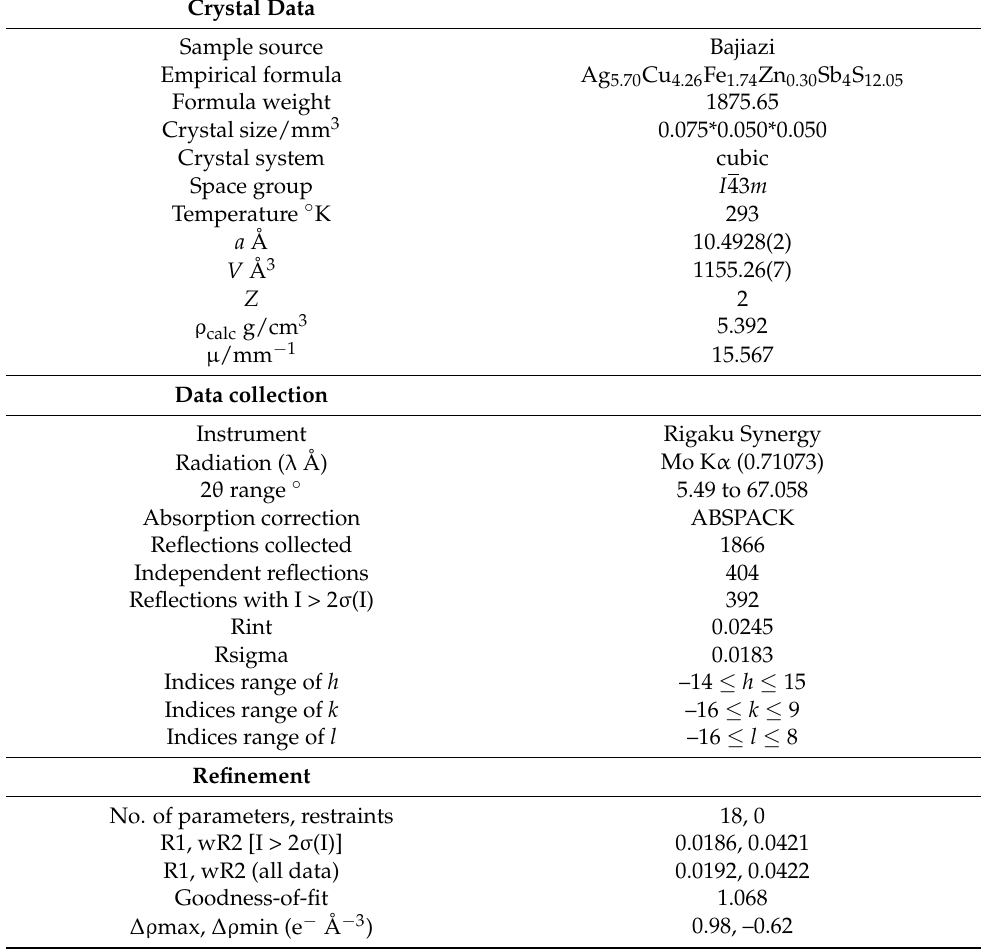
Table 2. Summary of crystal data and refinement.